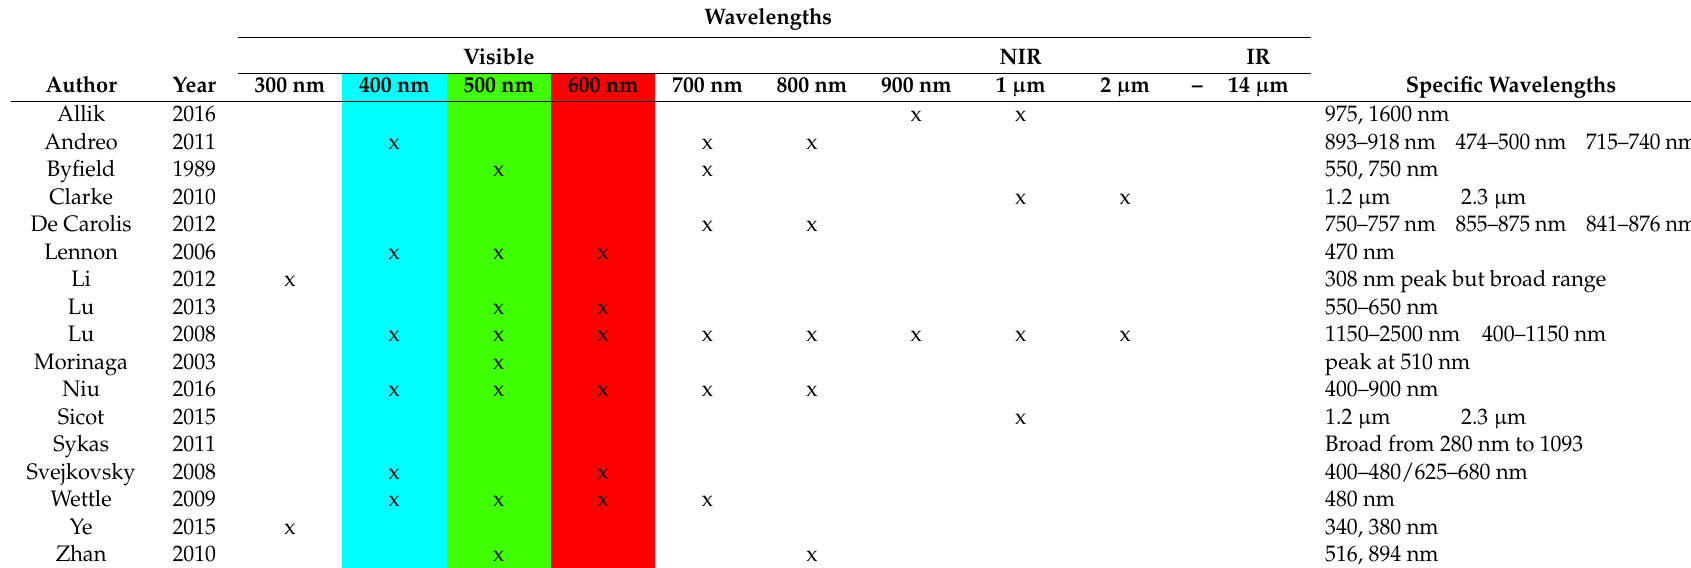
Table 6. Wavelengths Reported as Possibly Relating to Slick Thickness. (Visible color: blue, green,